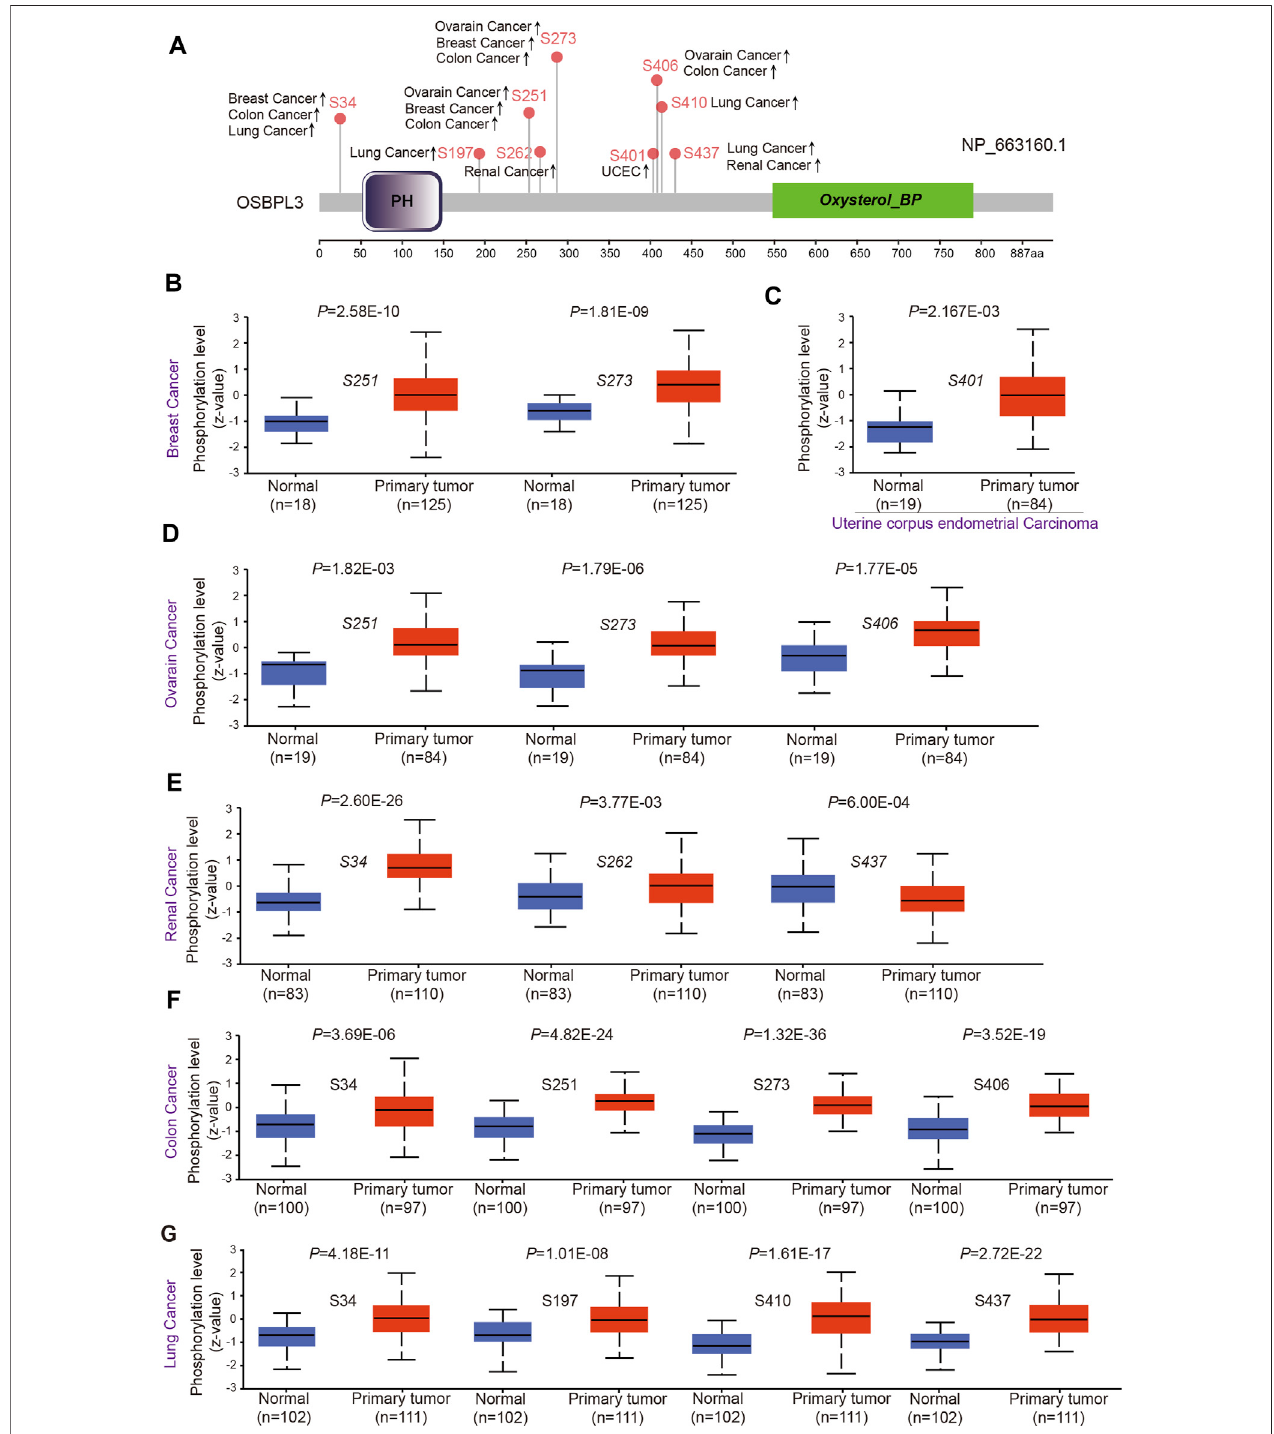
FIGURE 7 | Phosphorylation analysis of OSBPL3 protein in different tumors. (A) Expression level of OSBPL3 phosphoprotein sites (NP_663, 160.1, S34, S197, S251,S262,S273,S401,S406,andS437sites)betweenprimarytumorsandcorrespondingnormaltissuesviatheUALCANandCPTACdatasets,whicharedisplayed in the schematic diagram with positive results. (B – G) Box plots of phosphorylation analysis of OSBPL3 for different cancers, including breast cancer (B) , uterine corpus endometrial carcinoma (C) , ovarian cancer (D) , renal cancer (E ), colon cancer (F) , and lung cancer (G) .